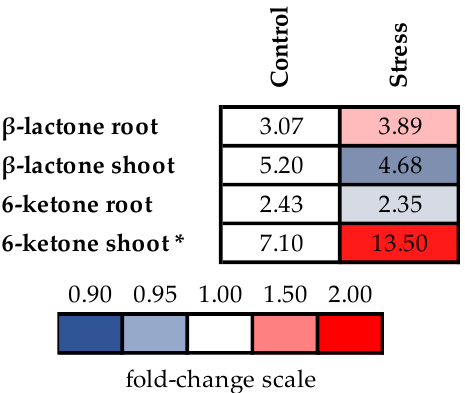
Figure 8. The effects of heavy metal stress on brassinosteroids content (ng/g dry weight) in roots and shoots of barley plants. The value in the control plants was taken as 1.0, the relative decrease is indicated in blue, the relative increase is indicated in red. Asterisks (*) indicate significant differences from the control variant ( p < 0.05).